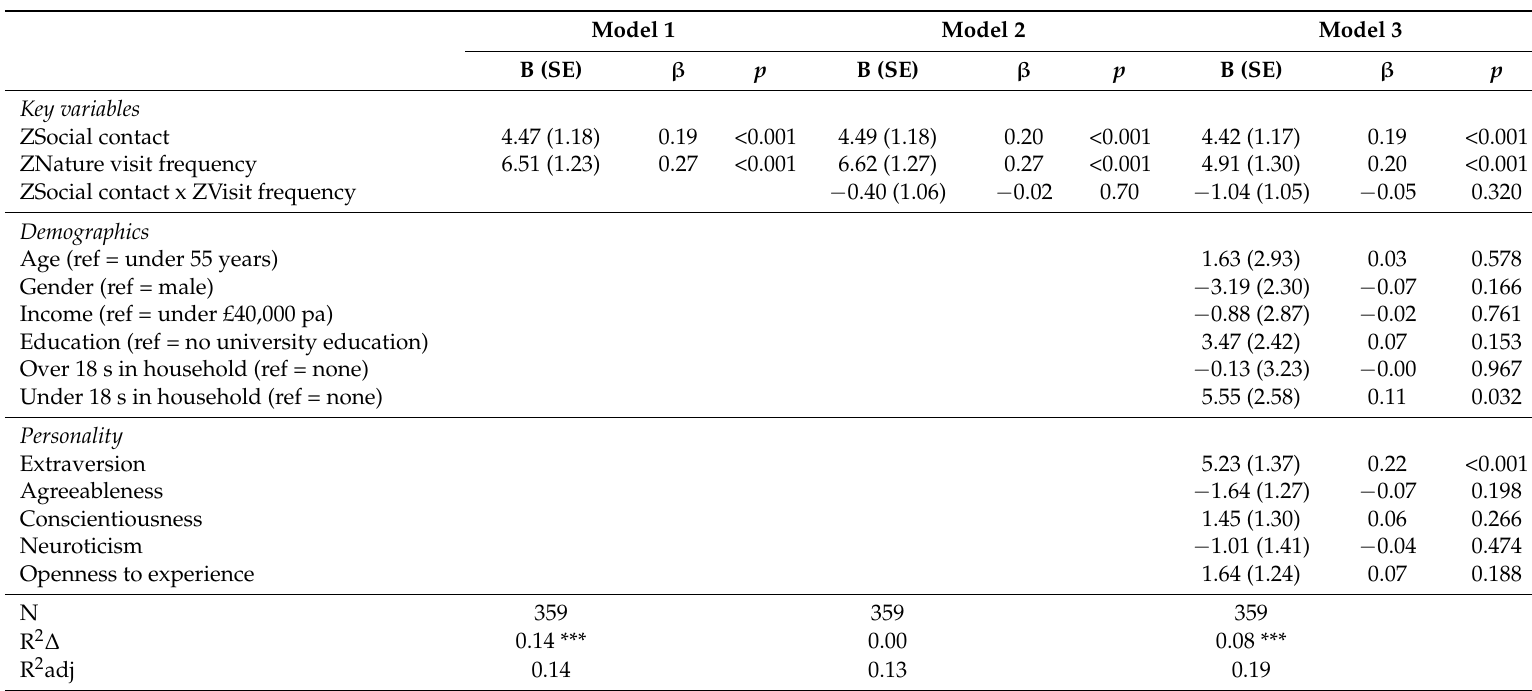
Table 3. Nature visit frequency*social contact. Results of multiple regression predicting subjective wellbeing, displaying: unstandardised regression coefficients (B); standard error (SE); standardised regression coefficients ( β ); and, significance ( p ) of